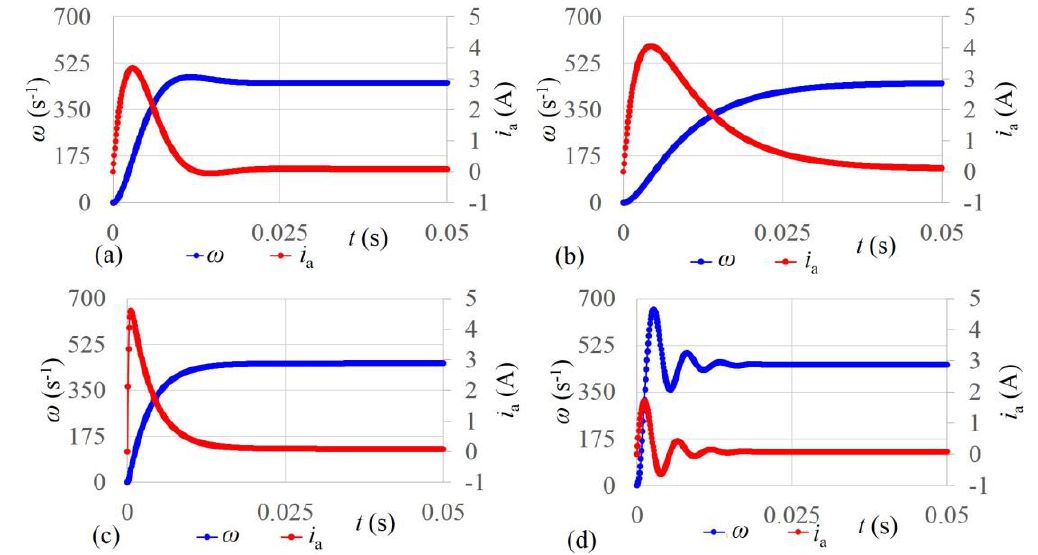
Figure 2. Simulated input responses: ( a ) SD1; ( b ) SD2; ( c ) SD3; ( d ) SD4.